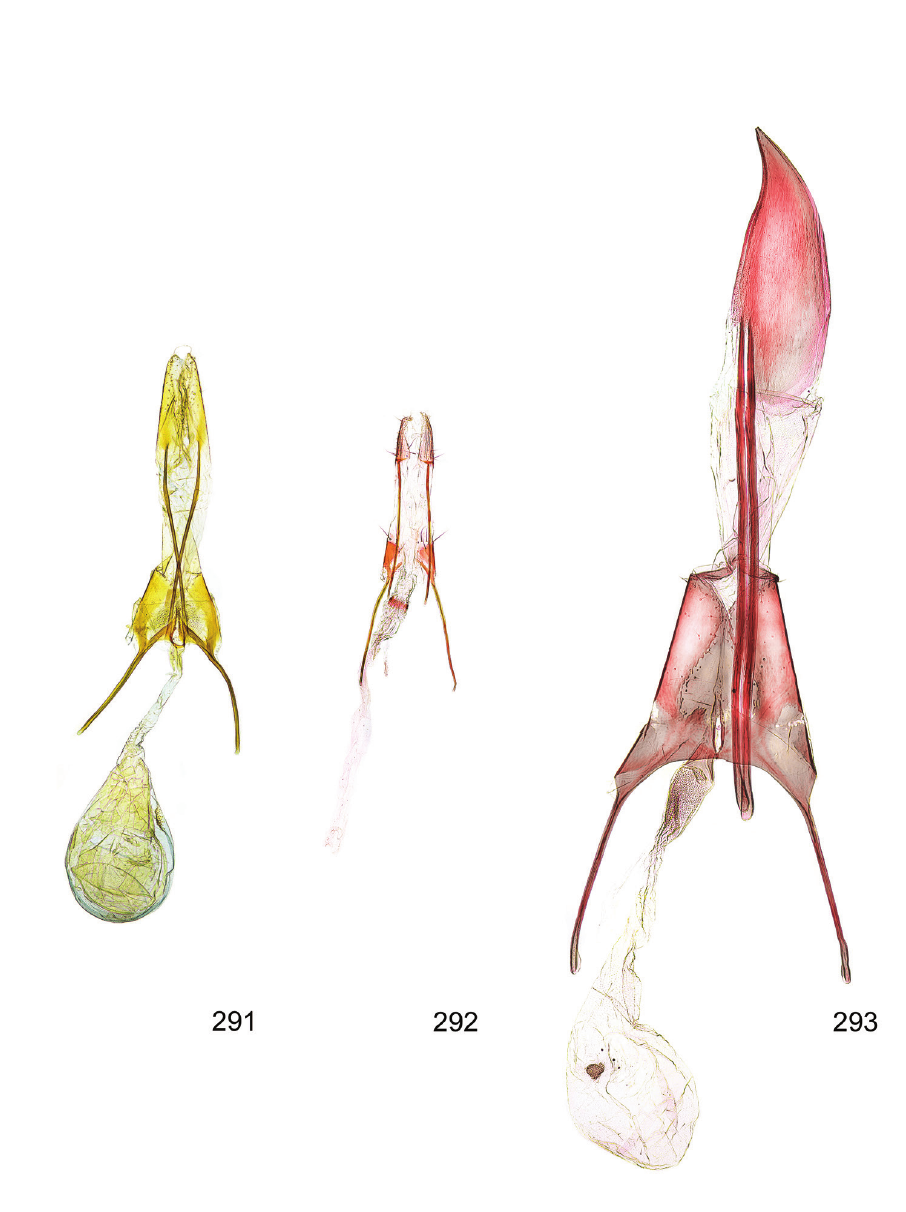
Figures 291–293. Megacraspedus female genitalia. 291 M. nupponeni sp. n. – Paratype, Russia, gen. slide 4/16.7.2017 K. Nupponen (RCKN) 292 M. leuca (Filipjev, 1929) – Paratype ( kaszabianus ), Mongolia, GU 16/1447 P.H. (HNHM) 293 M. lagopellus Herrich-Schäffer, 1860 – Hungary, gen. slide 16.657